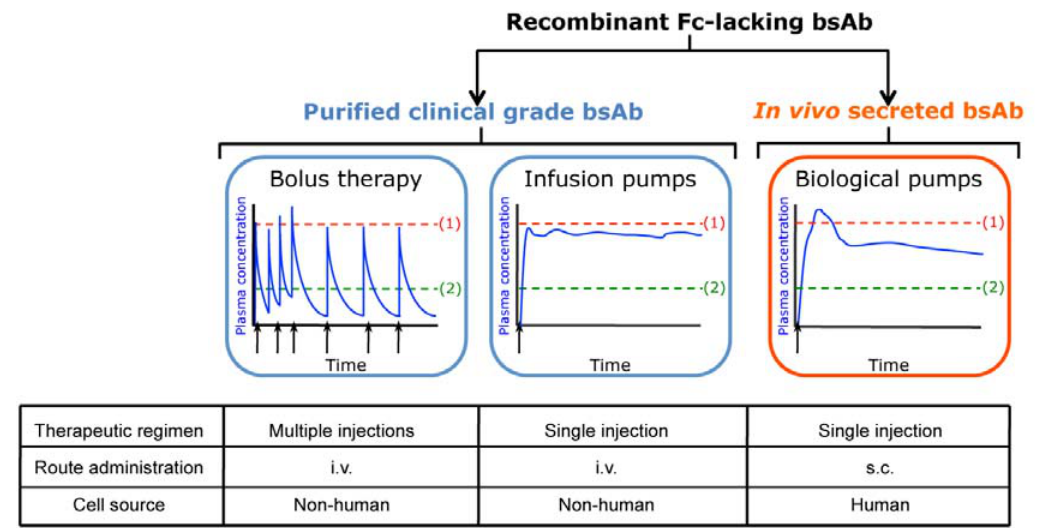
Figure 1. Schematic chart depicting advantages and limitations associated with the use of systemic administered purified clinical-grade bsAbs (bolus therapy or infusion pumps) and in vivo secreted bsAbs. Simulated pharmacokinetic profile of plasma bsAbs, ranging from subtoxic ( 1 ) to subtherapeutic ( 2 ).